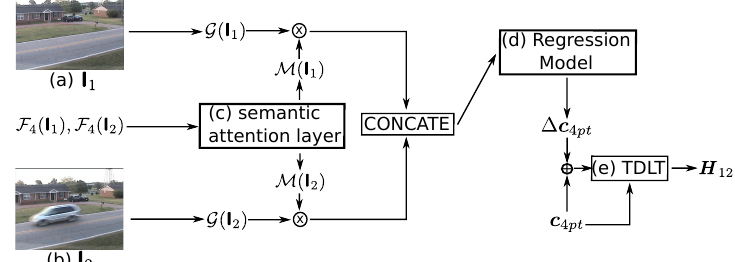
Figure 2. Architecture of the proposed homography estimator. The estimator takes as inputs the paired images ( a ) I 1 and ( b ) I 2 and their corresponding deep features F 4 ( I 1 ) and F 4 ( I 2 ) , and gets as the